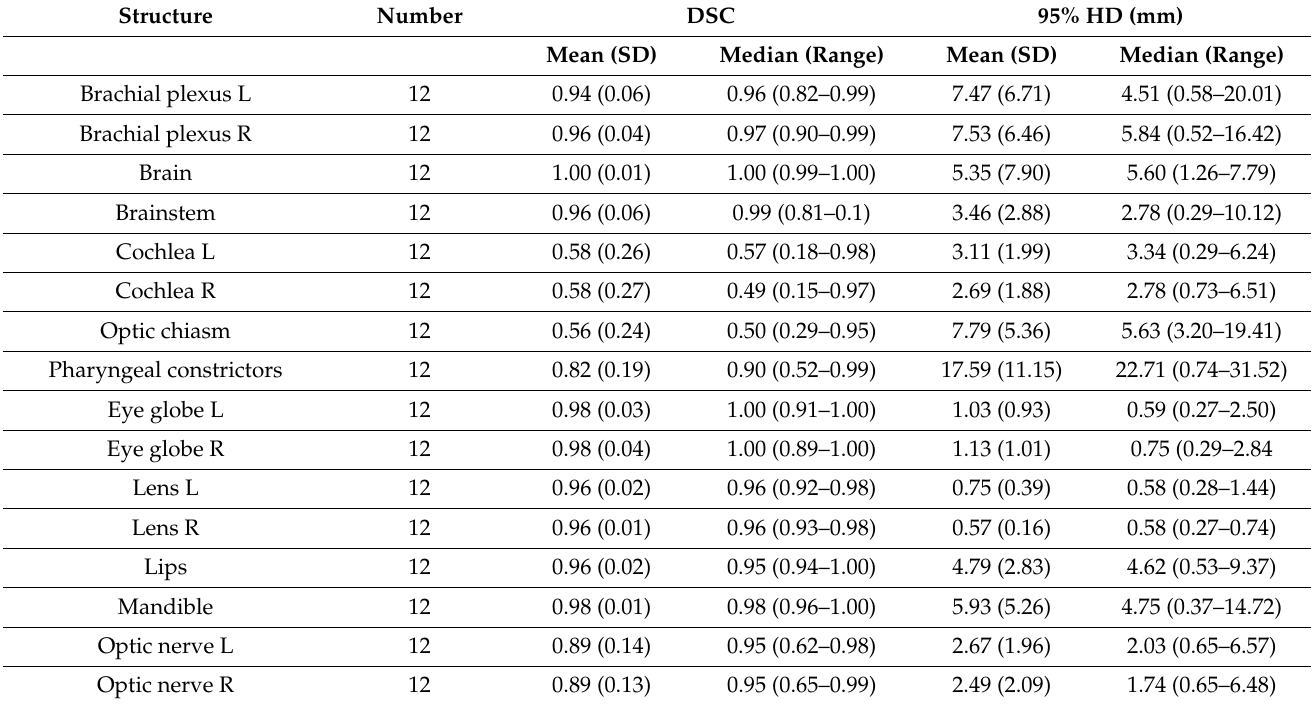
Table 1. Values obtained quantifying the comparison between manual and automated contours in terms of DICE (DSC) and 95% Hausdorff distance (HD) for the organs object of the